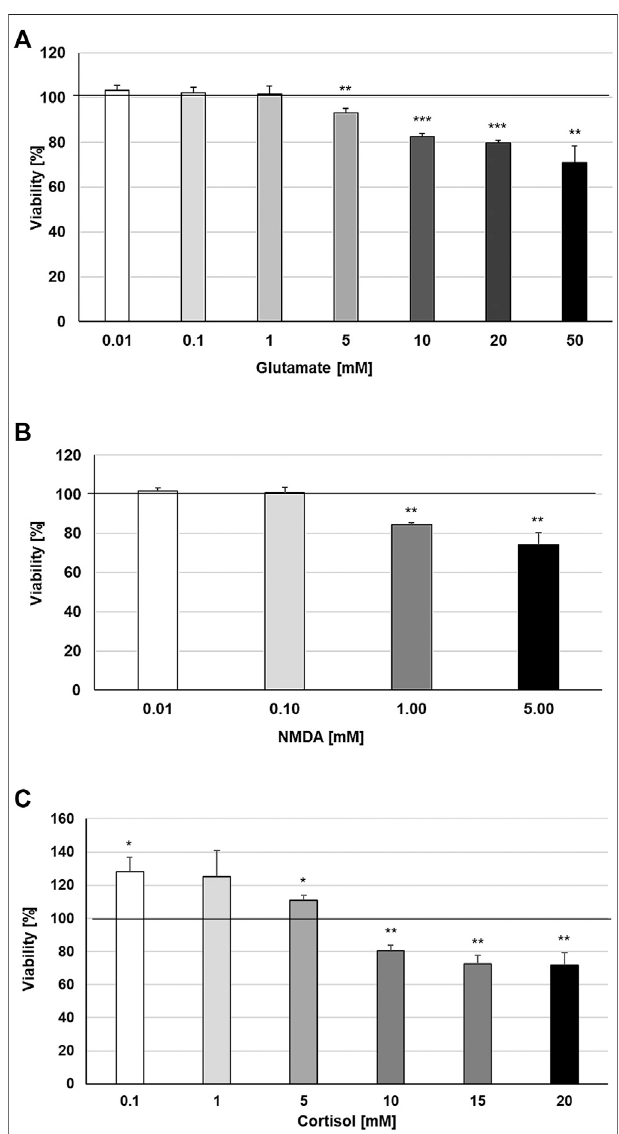
FIGURE 4 | Effects of 48 h treatment with (A) glutamate, (B) N-methyl- D-aspartate or (C) Cortisolon the viability ofmouse SIM-A9microglia.Viability was measured by PrestoBlue ® assay. Values [in % viability of untreated control (control (cid:2) 100% viability)] are given as mean + SEM; signi fi cance (by T-TEST): * p ≤ 0.05, ** p ≤ 0.01 or *** p ≤ 0.001 vs. untreated control; n (cid:2) 4.